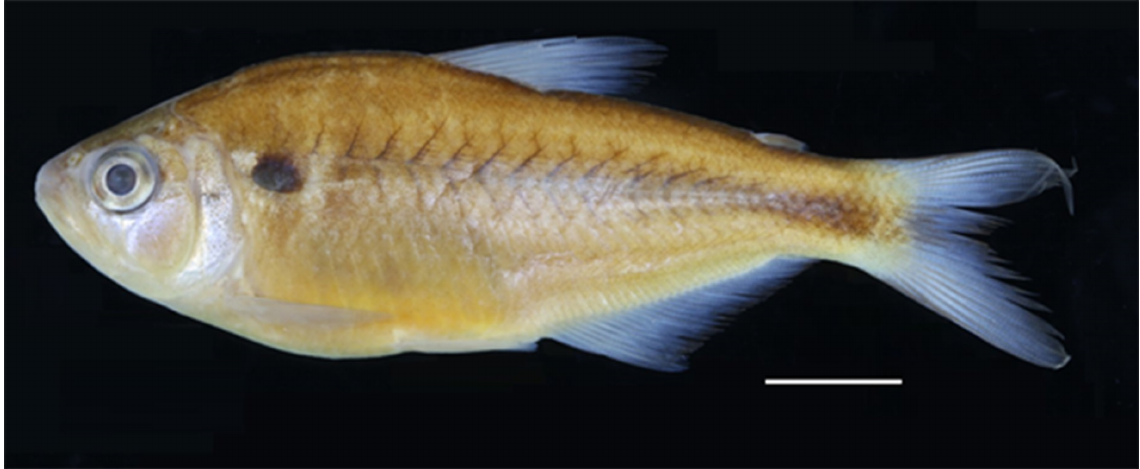
Fig. 13. Astyanax moorii ( Boulenger, 1892 ) , 64.7 mm SL, Creek near the Manso Hydroelectric Plant, Cuiabá River drainage, Fazenda Nova region, Mato Grosso State, Brazil (MNRJ 29284). Scale bar = 1